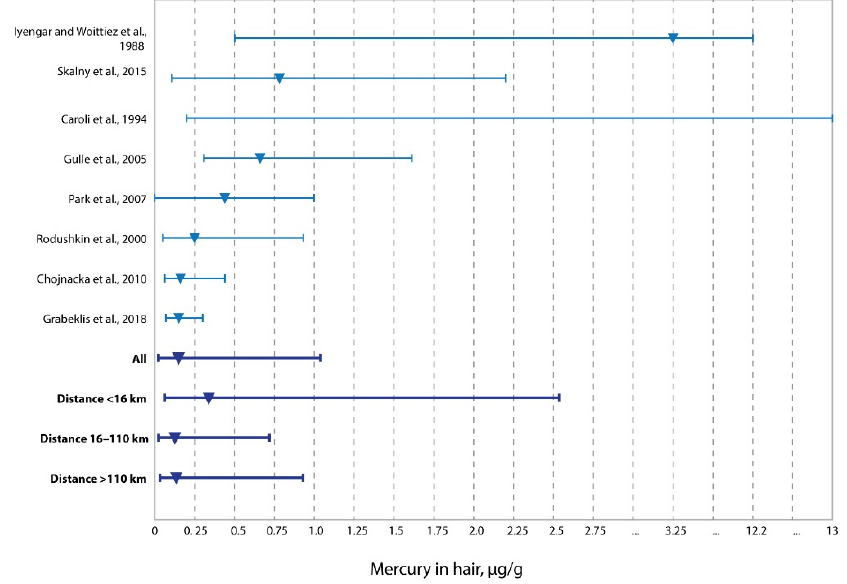
Figure 4. Concentrations of mercury in the hair of residents living at different distances from oil and gas production fields vs. literature data (medians and ranges) [48–52, 55–57].